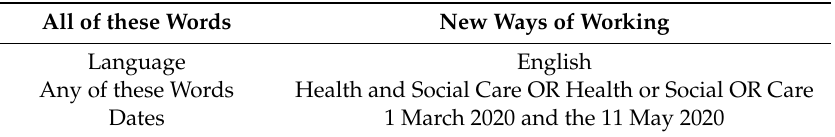
Table 1. Twitter Advanced